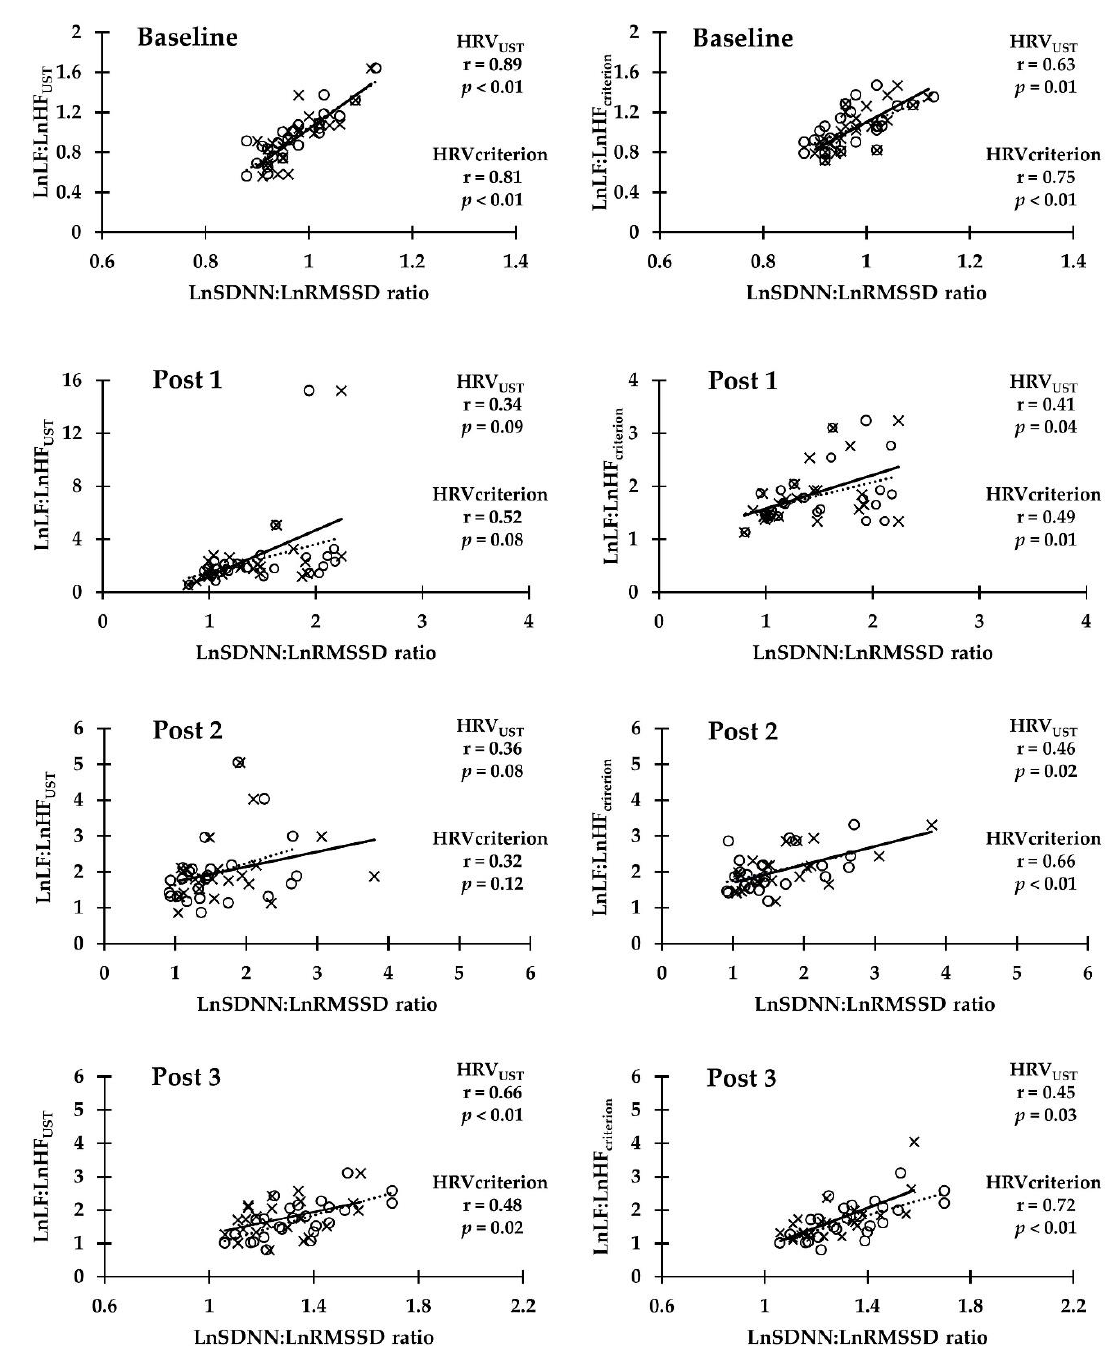
Figure 3. Pearson correlation coe ffi cient of the relationship between LnSDNN:LnRMSSD ratio and LnLF:LnHF ratio (1 min and criterion) at baseline, post exercise 0–5 min (Post 1), post exercise 5–10 min (Post 2), and post exercise 25–30 min (Post 3) in Yo-Yo intermittent recovery test level 1. Scatter plots between 1 min LnSDNN:LnRMSSD ratio and LnLF:LnHF ratio are presented as open circles (dotted line). Scatter plots between criterion of LnSDNN:LnRMSSD ratio and LnLF:LnHF ratio are presented as cross marks (solid